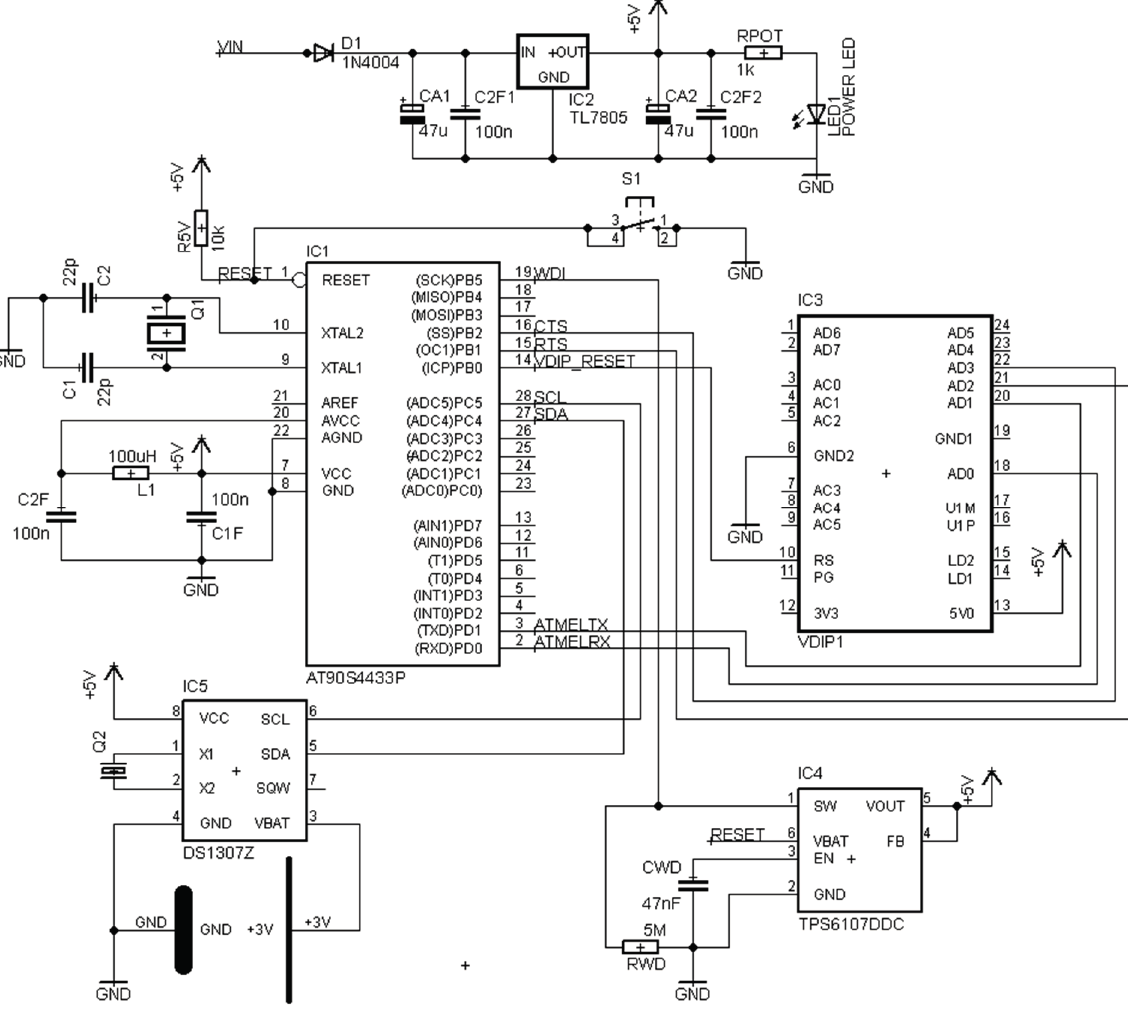
Figure 2. Master schematic final